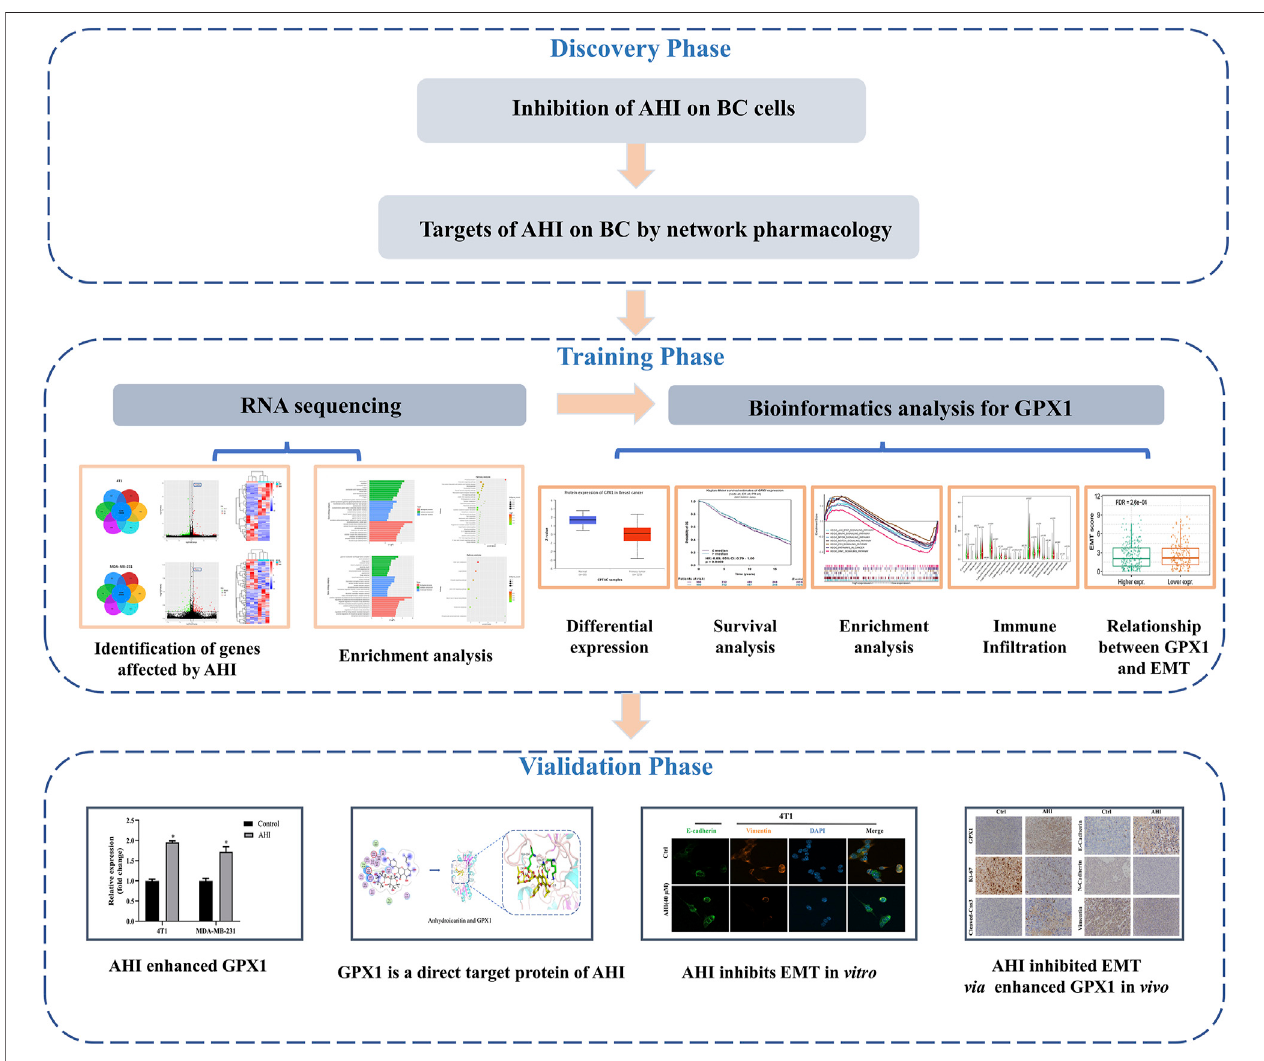
FIGURE 1 | Work fl ow chart of the